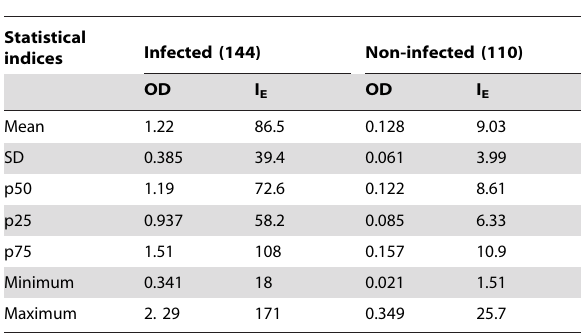
Table 2. Diagnostic sensitivity, specificity, and positive and negative predictive values (cut off 17%, 95% CI) for serum samples from people with a diagnosis of Opisthorchis felineus infection confirmed by the detection of O. felineus eggs in their stool, serum samples from Opisthorchis sp. -free people, and serum samples from people suffering from other parasitic or non-parasitic infections. a Opisthorchis infection ELISA